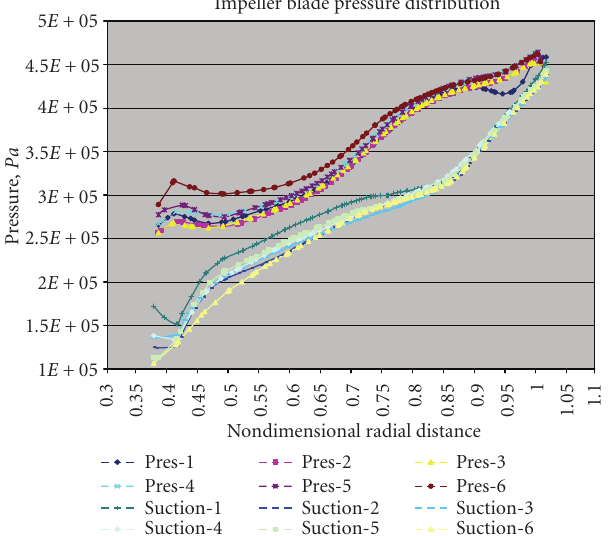
Figure 9: Pressure loading on impeller at Q design